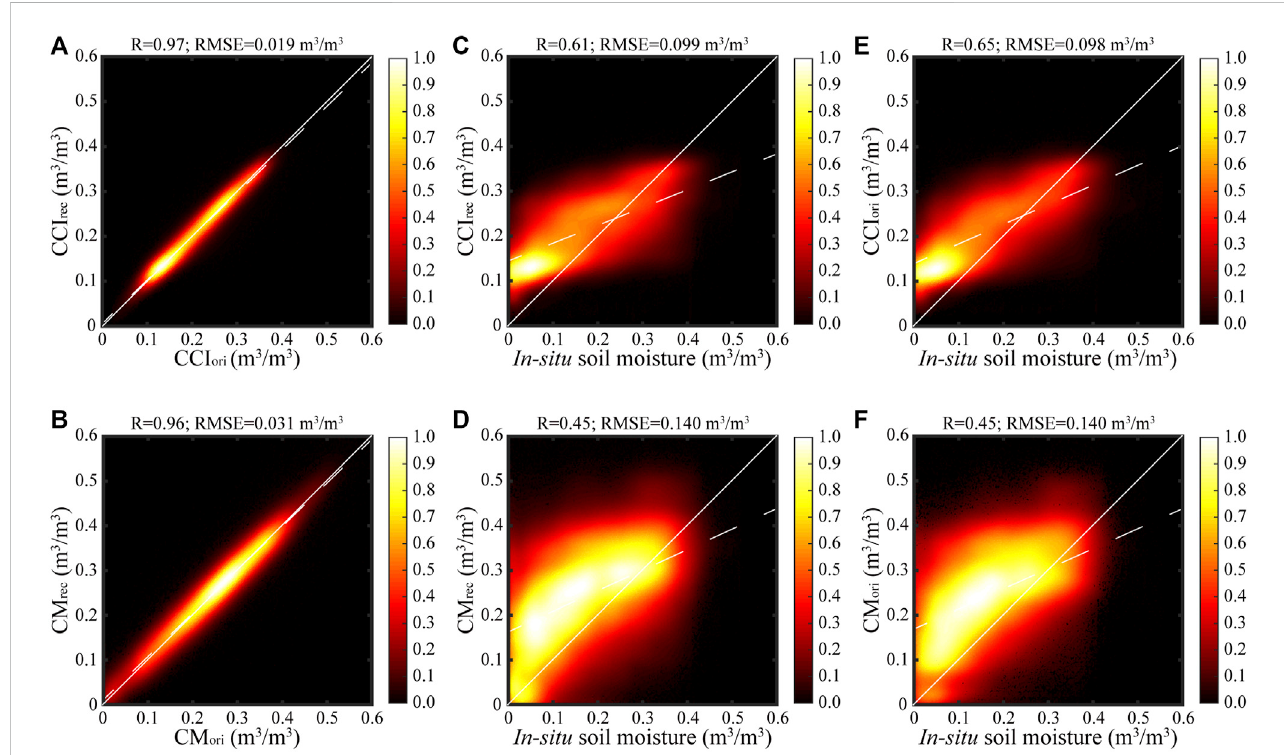
FIGURE 10 CCI rec against CCI ori (A) , CM rec against CM ori (B) , CCI ori against in-situ observations (C) , CM ori against in-situ observations (D) , CCI rec against in-situ observations (E) , and CM rec against in-situ observations (F) from January 2012 to December